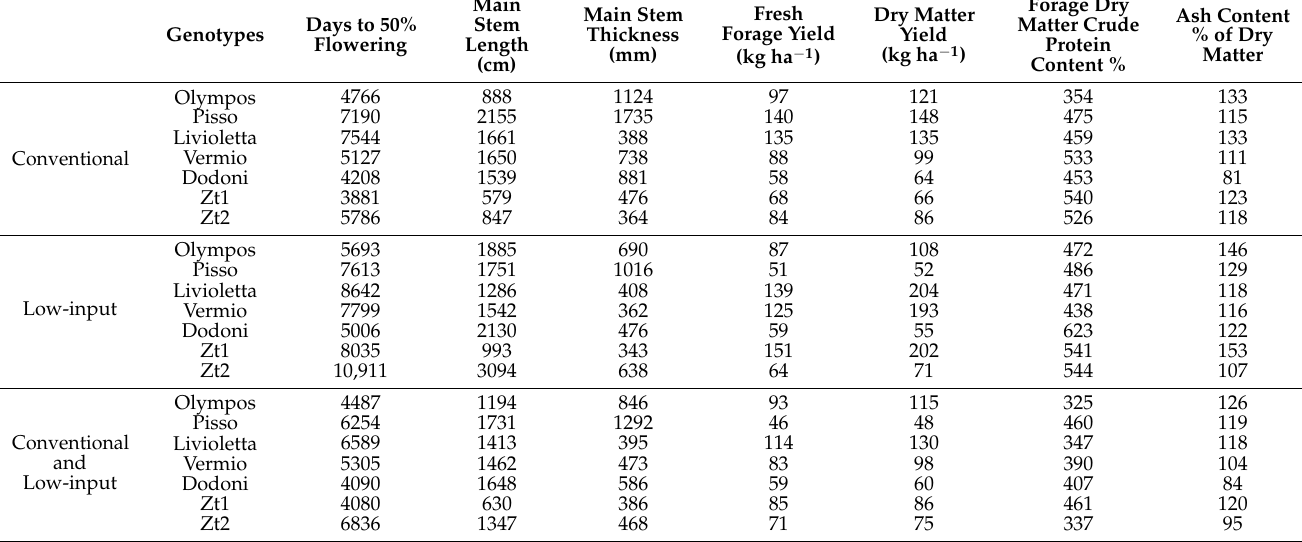
Table 3. Trait stability index across genotypes for the two farming systems: days to 50%